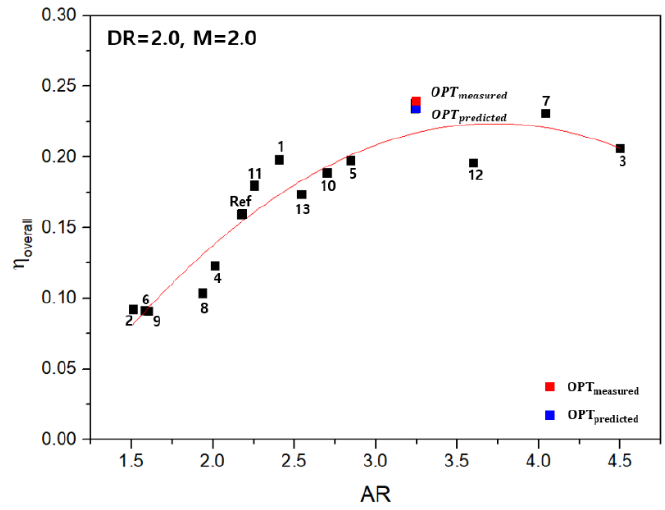
Figure 13. Overall averaged FCE for area ratio (M = 2.0).